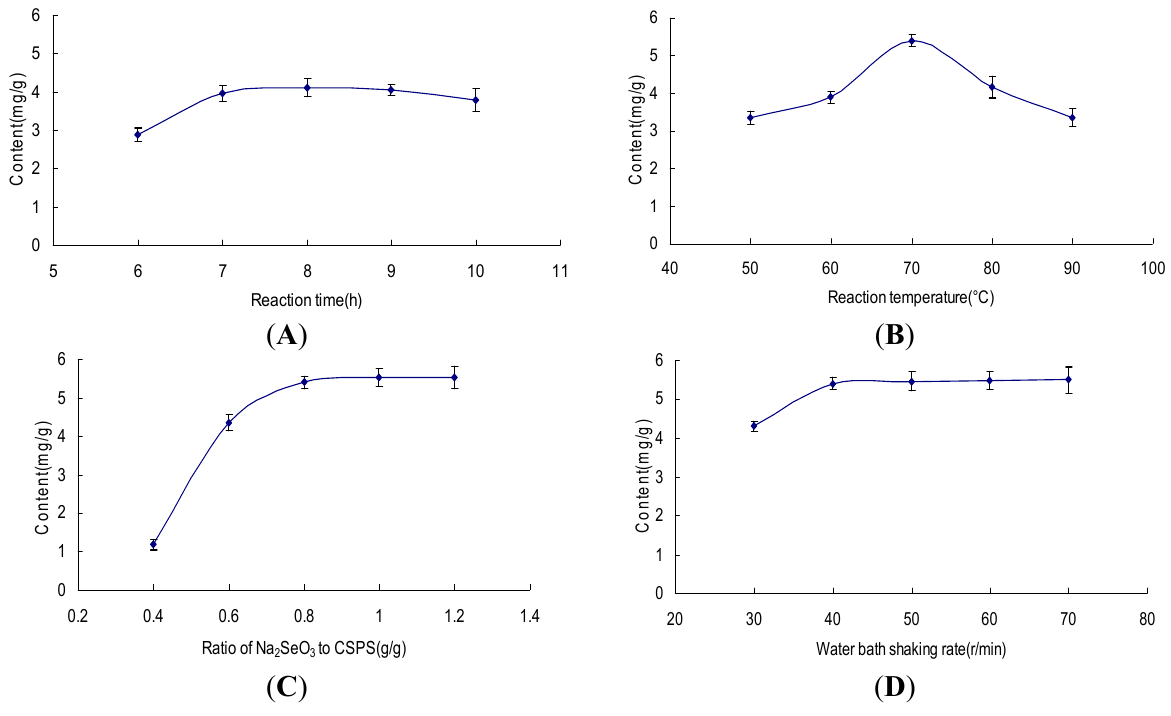
Figure 1. Effect of reaction time, temperature, ratio of Na SeO to Capparis spionosa L. 2 3 polysaccharide (CSPS) and water bath shaking rate on Se content. ( A ) reaction temperature SeO to CSPS 0.8 g/g, water bath shaking rate 40 r/min; ( B ) reaction 60 °C, ratio of Na 2 3 time 7 h, ratio of Na SeO to CSPS 0.8 g/g, water bath shaking rate 40 r/min; ( C ) reaction 2 3 time 7 h, reaction temperature 70 °C, water bath shaking rate 40 r/min; ( D ) reaction time SeO to CSPS 0.8 7 h, reaction temperature 70 °C, ratio of Na 2 3